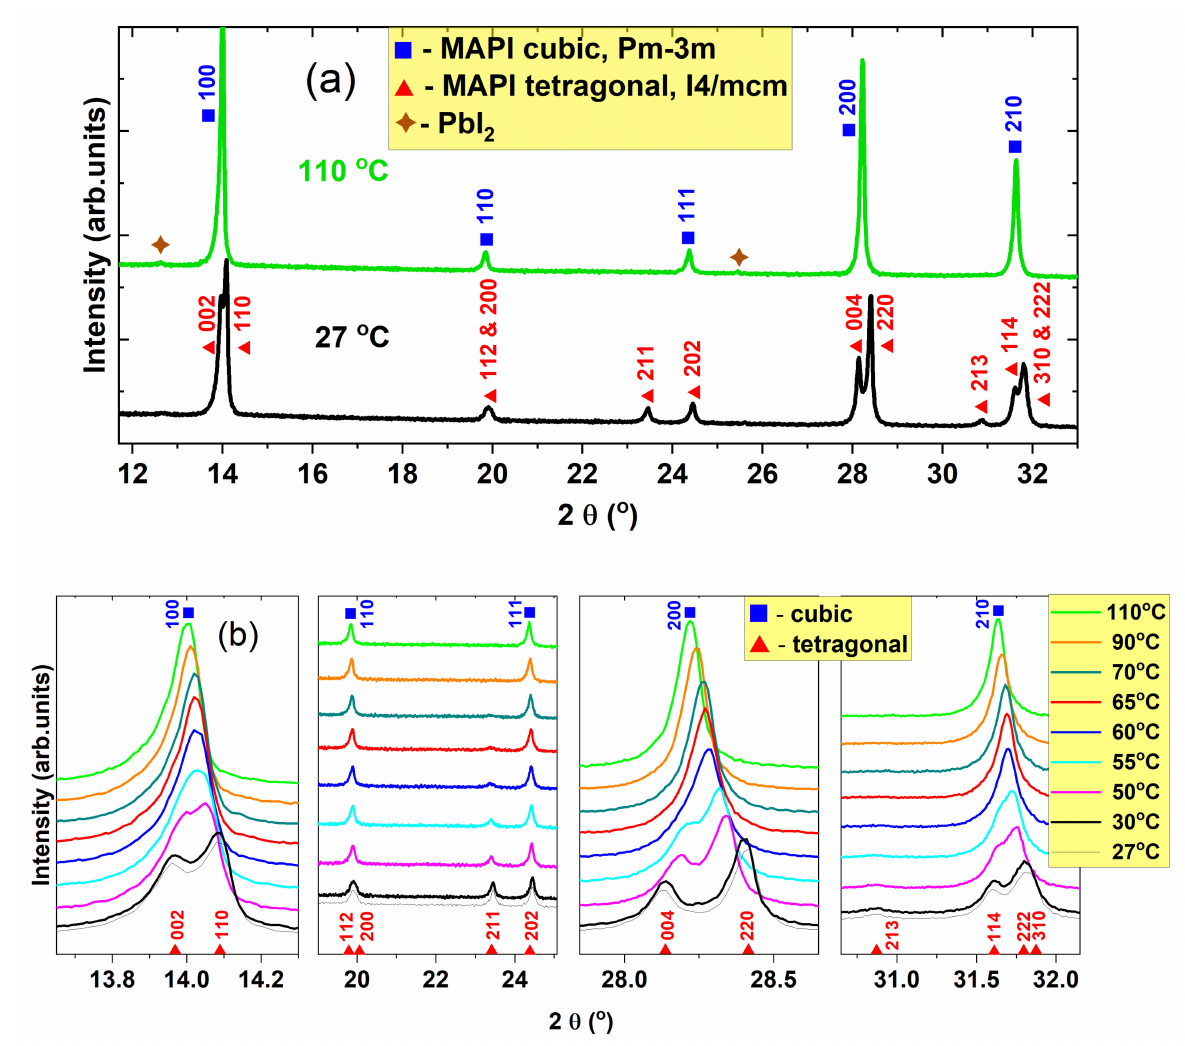
Figure 1. XRD patterns: ( a ) recorded at 27 ◦ C and 110 ◦ C, showing the phase identification and line indexing; ( b ) XRD at different temperatures, showing zoomed views of the significant regions. The diffractograms are represented after removing the contribution of CuK α 2 radiation. The diffractograms were vertically